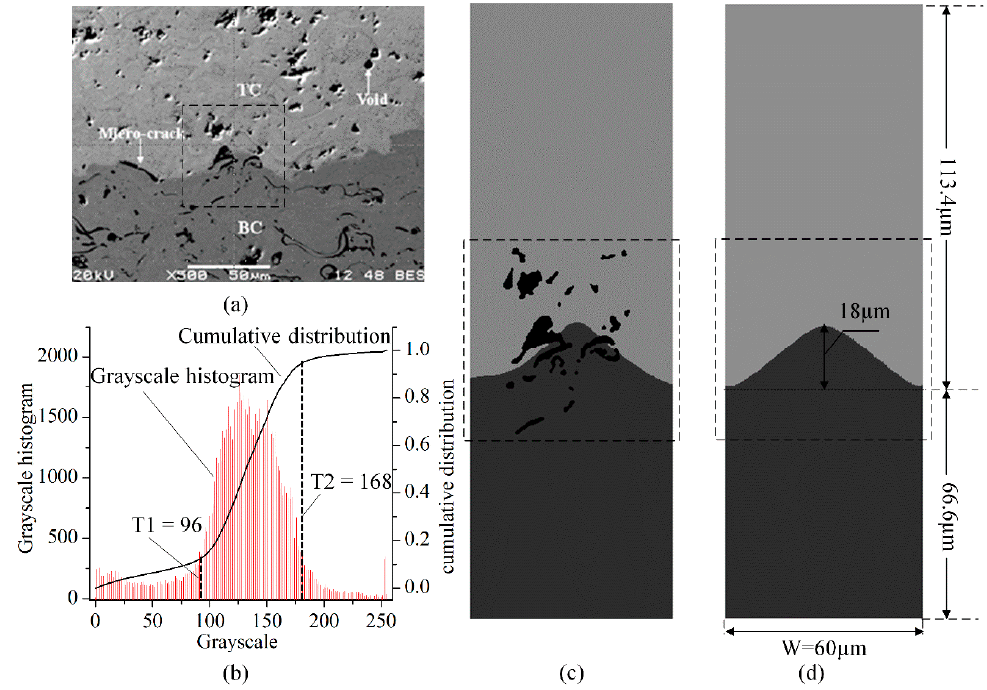
Figure 1. ( a ) SEM image of cross-sectional microstructures of TBC [7], ( b ) grayscale histogram and cumulative distribution for SEM images, ( c ) SEM image based FE mesh, and ( d ) FE mesh with idealized interface.